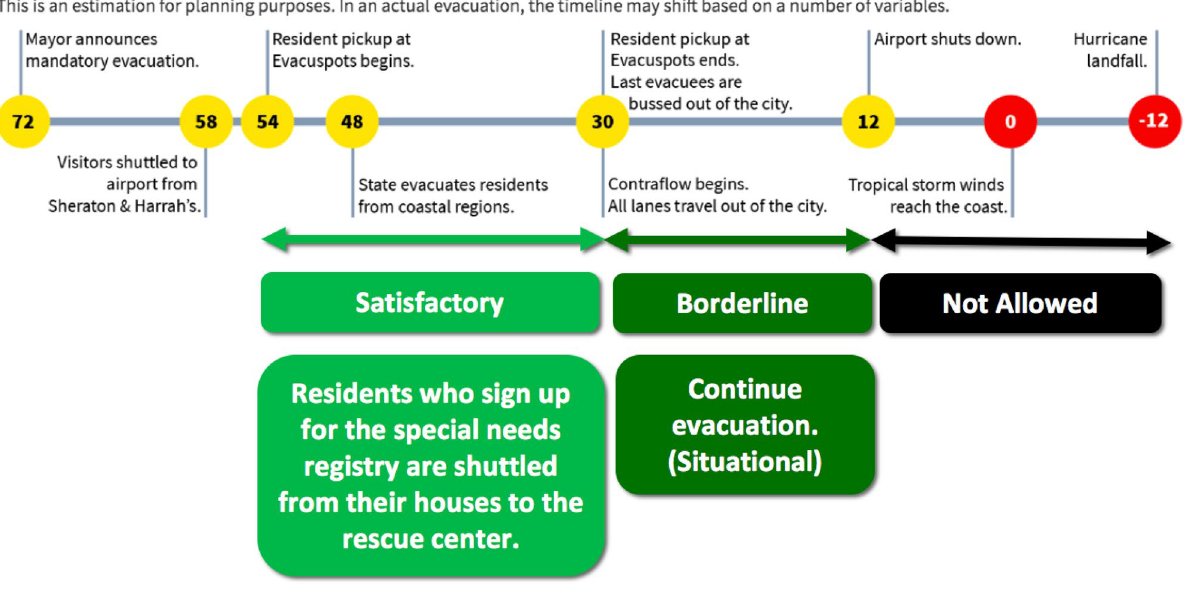
Figure 2. 72-h evacuation timeline in New Orleans. This pre-hurricane evacuation timeline is adapted from 43,44